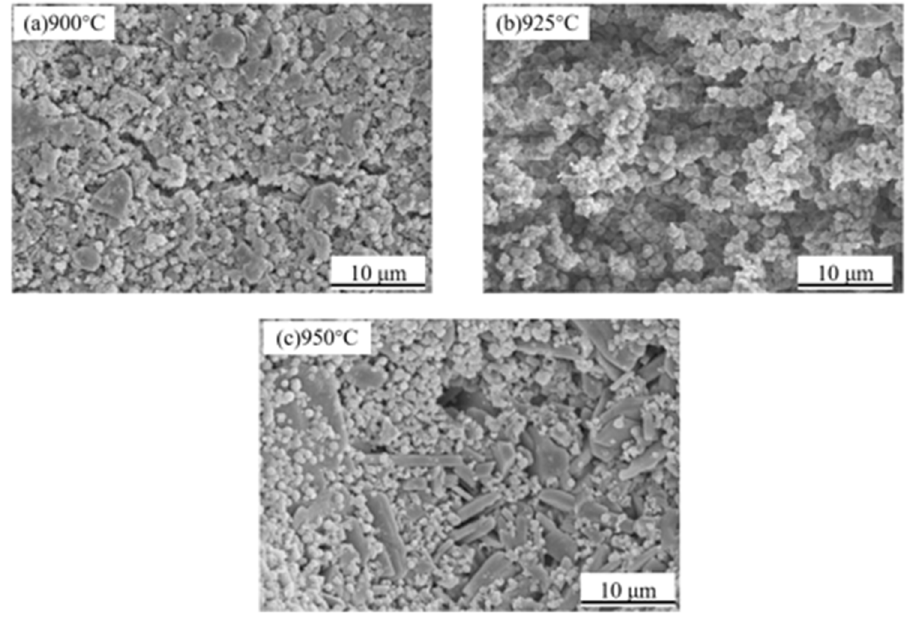
Figure 4. SEM images of microcrystalline glass samples at different crystallization temperatures: ( a ) 900 °C, ( b ) 925 °C, and ( c ) 950 °C.